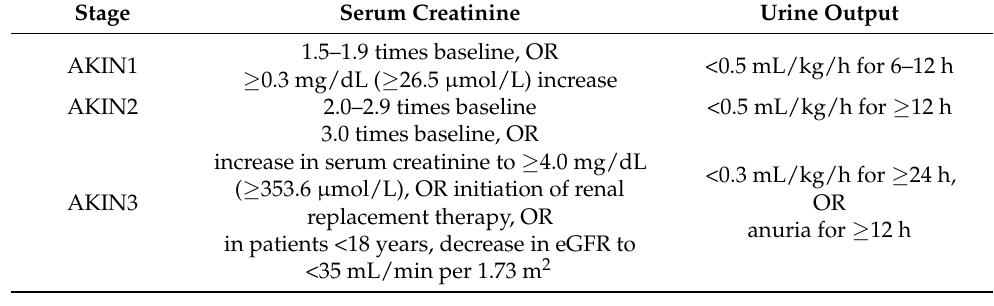
Table 1. AKI staging according to the KDIGO guidelines [10].